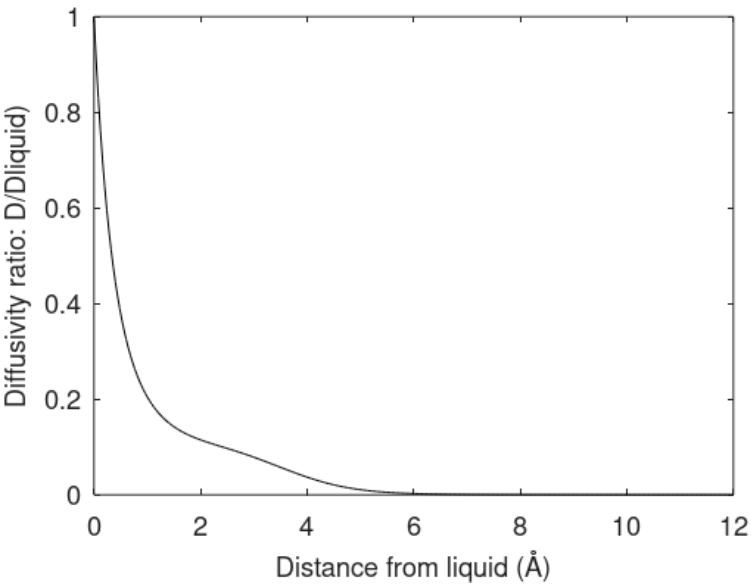
Figure 11. Diffusivity coefficients through hydrate/liquid water interface relative to liquid side interface boundary diffusivity coefficient. The same function applies to both CH 4 and CO 2 but the liquid side value will be different, as illustrated in the next section. Liquid side of interface is 0 Å and hydrate side of interface is 12 Å.